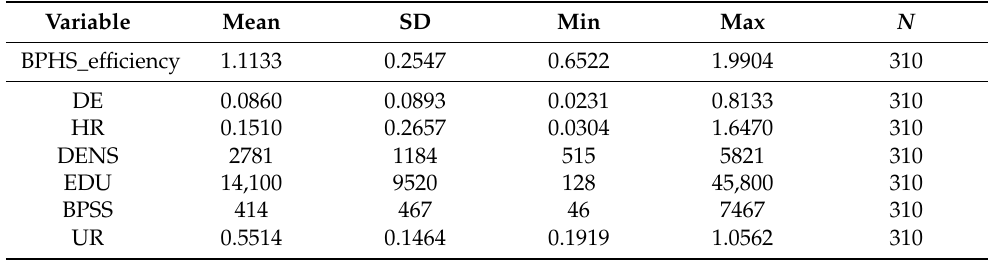
Figure 4. Geographic map of the mean value of public health service provision efficiency in 31 provinces in China from 2009 to 2018. Table 6. Descriptive statistics of variables.